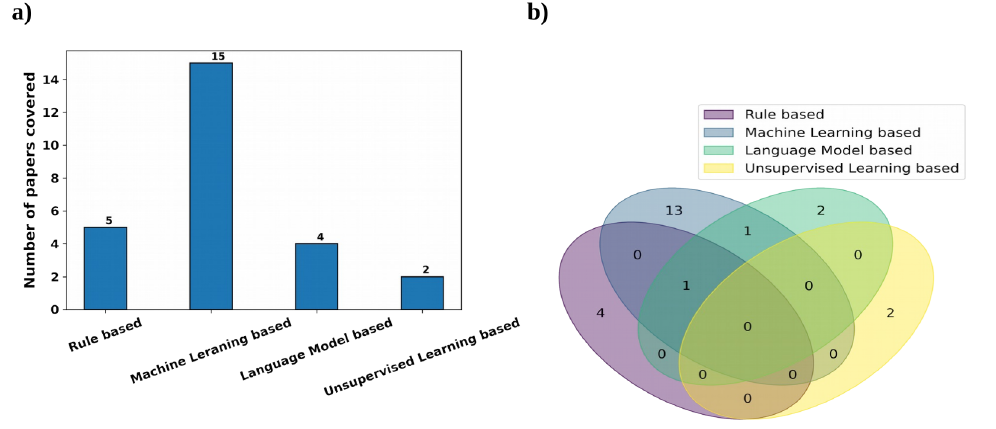
Figure 4. Representation of the clinical RE research papers used, based on the variety of the methods by using ( a ) a bar chart and ( b ) a Venn